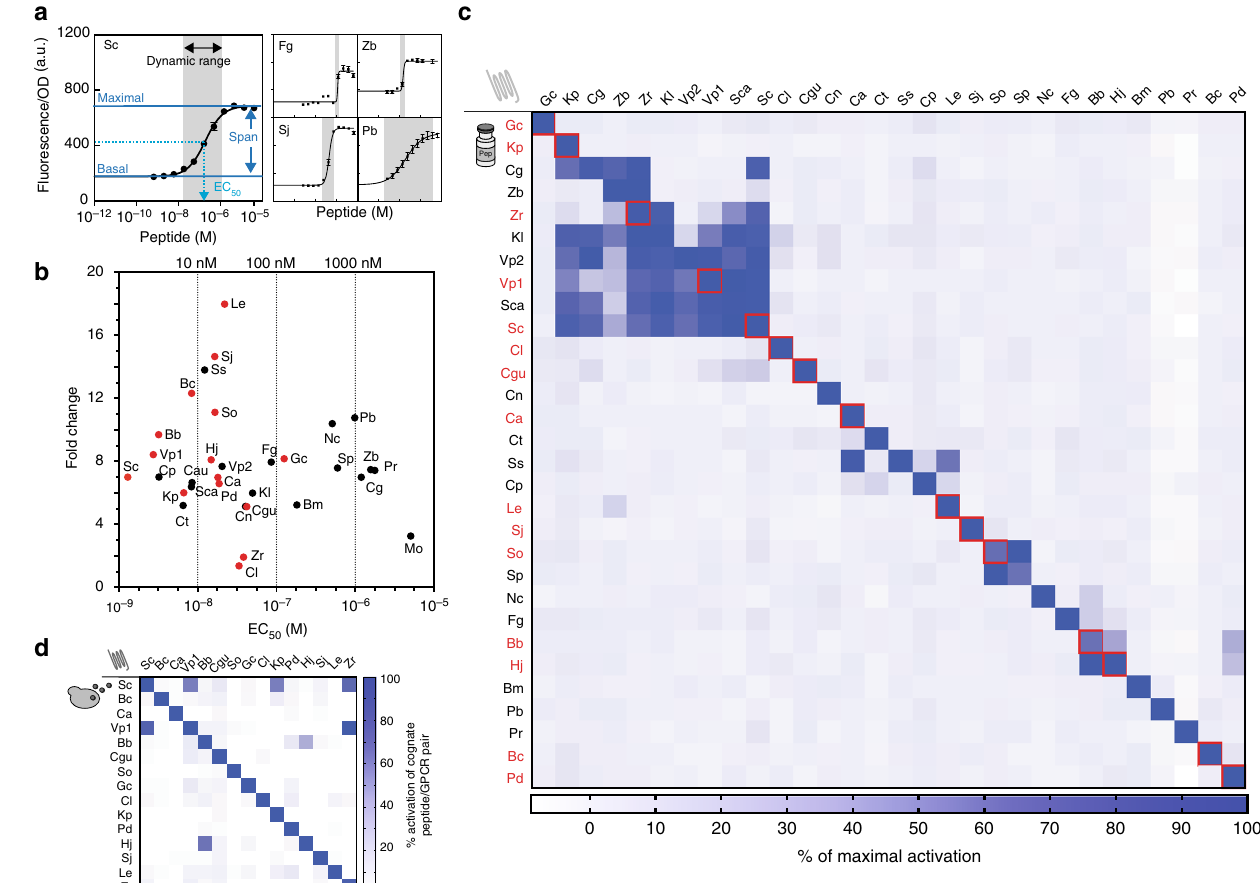
Fig. 2 Peptide-GPCR pairs exhibit tunable response characteristics, are naturally orthogonal, and peptides are functionally secreted. a Experimental framework for GPCR characterization. Performance of each peptide-GPCR pair was evaluated by recording its dose-response to synthetic cognate peptides, using fl uorescence as a read-out. Parameter values for basal and maximal activation, fold change, EC 50 , dynamic range (given through Hill slope) were extracted by fi tting each curve to a four-parameter non-linear regression model using PRISM GraphPad. Experiments were done in triplicates and errors represent the SD. Dose-response curves of GPCRs (Sc.Ste2, Fg.Ste2, Zb.Ste2, Sj.Ste2, Pb.Ste2) with different response behaviors are featured. b The GPCRs cover a wide range of response parameters. The EC 50 values of peptide-GPCR pairs are plotted against fold change in activation. Experiments were done in triplicate and parameter errors can be found in Supplementary Table 5. c GPCRs are naturally orthogonal across non-cognate synthetic peptide ligands. A 30 × 30 orthogonality matrix was generated by testing the response of 30 GPCRs across all 30 peptide ligands. The test concentration was set at 10 µ M of a given peptide ligand. The fl uorescence signal for maximum activation of each GPCR (not necessarily its cognate ligand) was set to